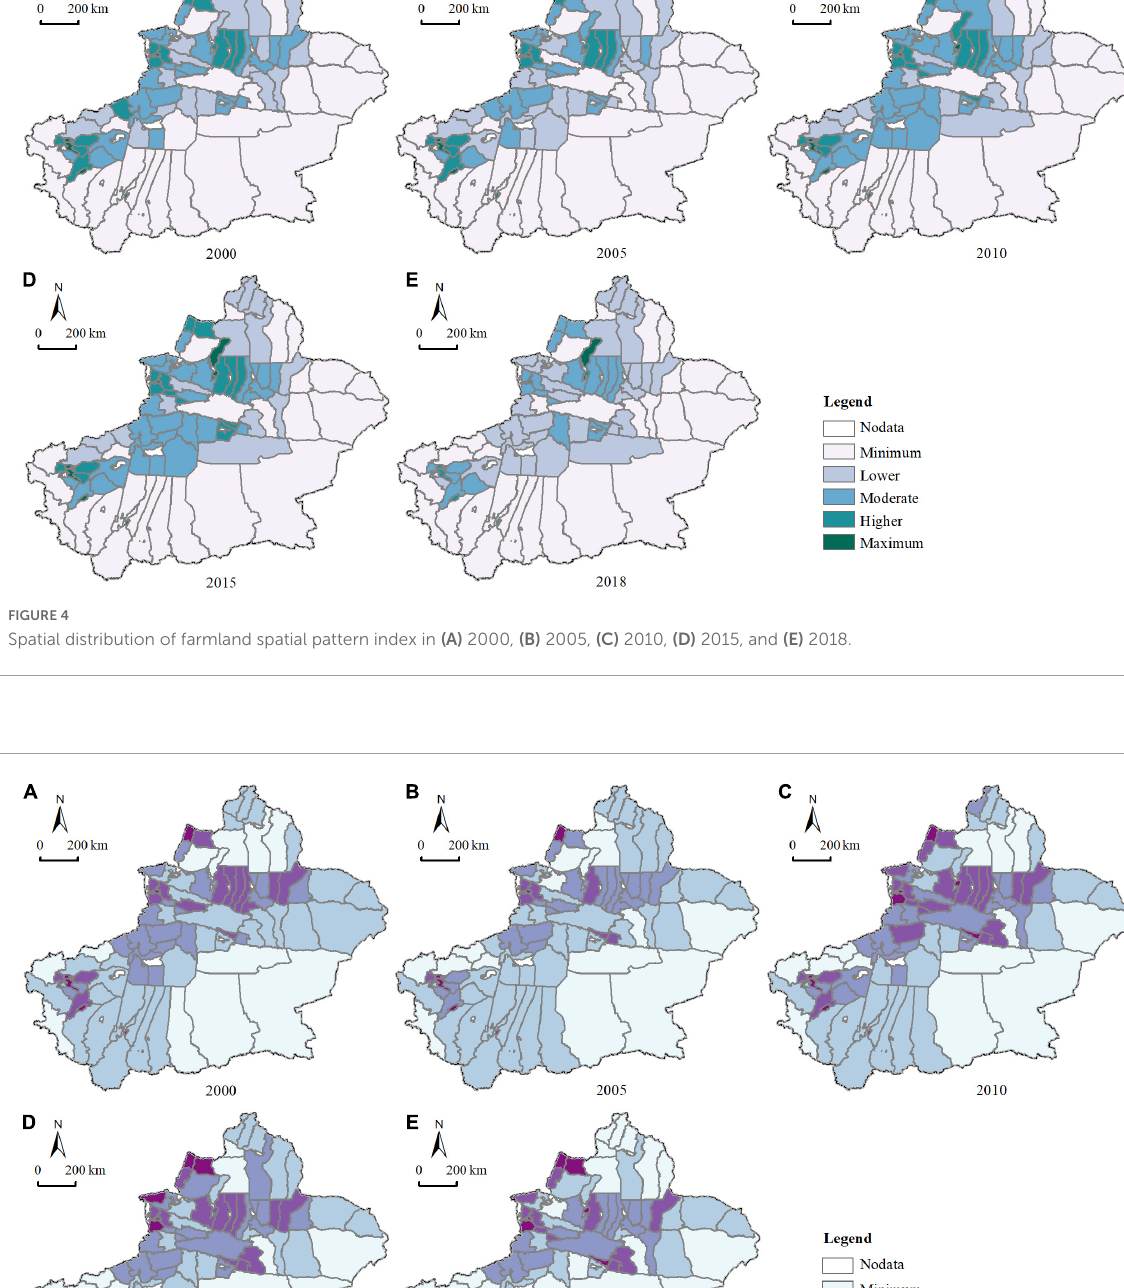
Frontiers in Ecology and